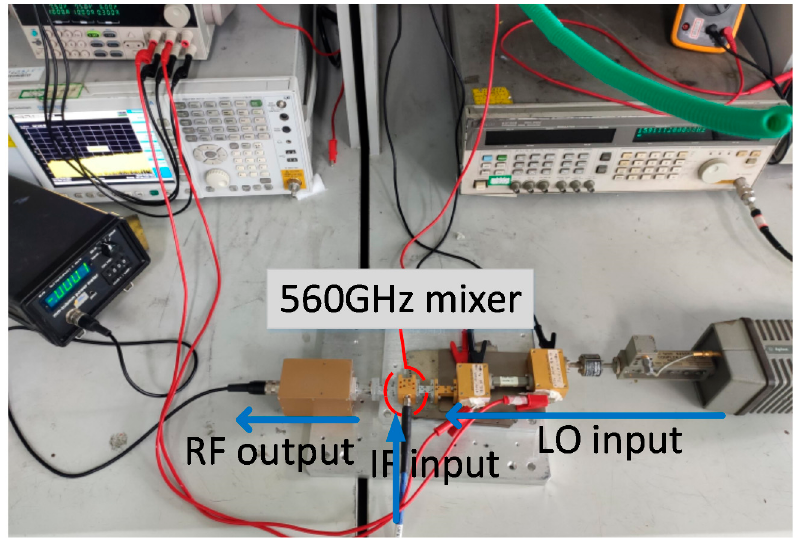
Figure 11. The test platform of the sub-harmonic mixer.